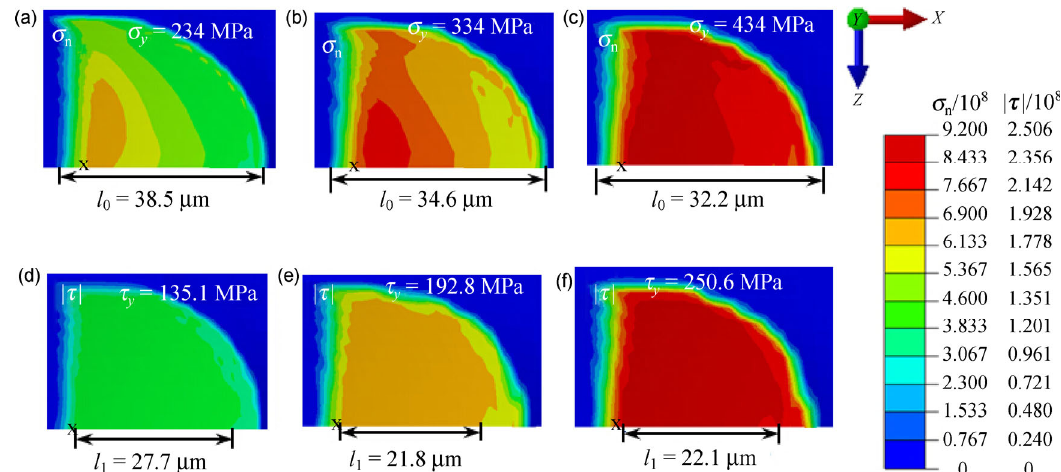
Fig. 2 Distributions of the normal contact pressure under axial force 0.8 N F  , with a growth of yield strength  n substrate are the same. The location of indenter tip is marked by a small